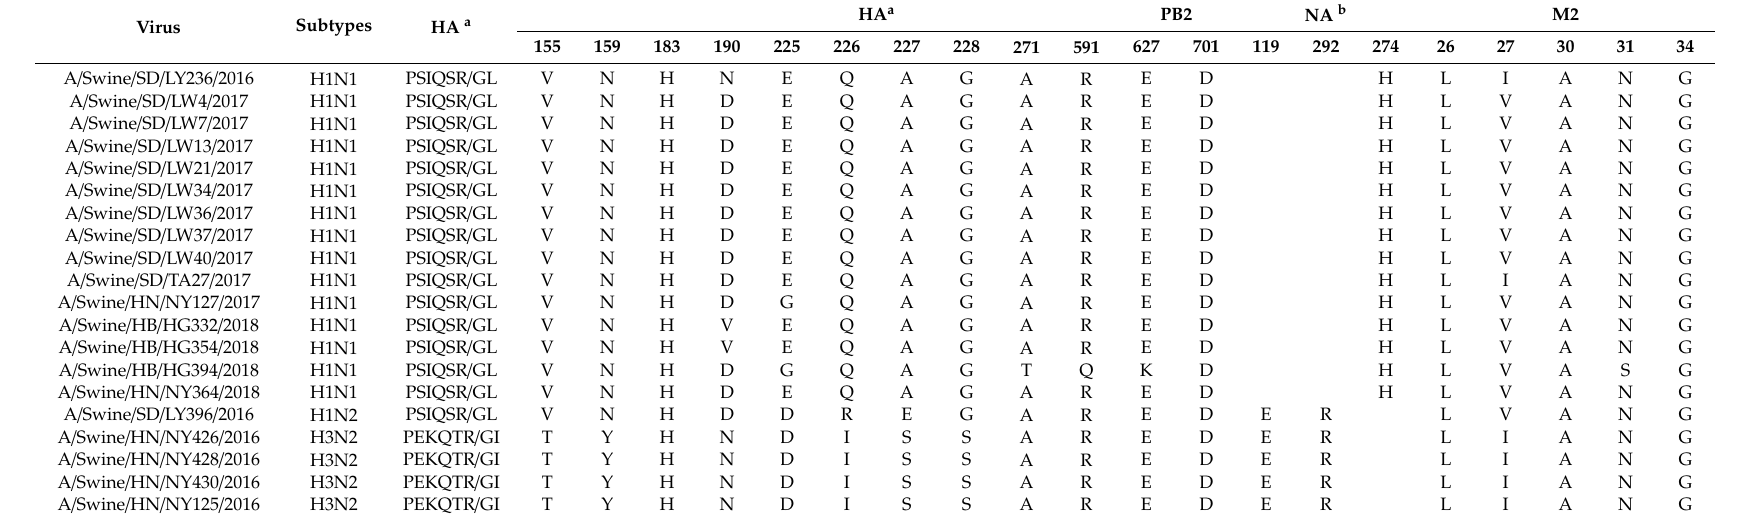
Table 3. Receptor binding sites and mutant sites analysis of the